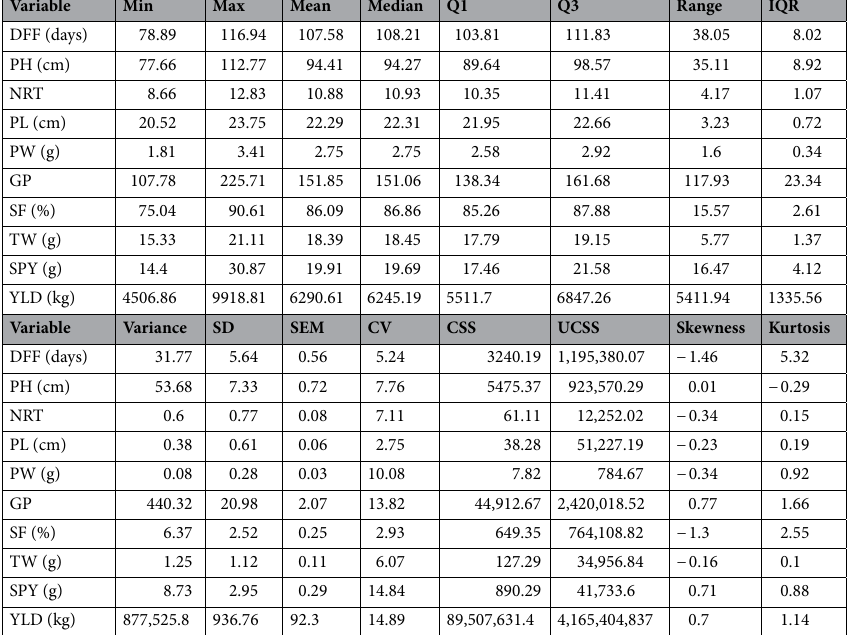
Table 1. Phenotypic variability and Descriptive statistics of traits under study across the environments. Var, Variable; DFF, days to fifty percent flowering; PH, plant height; NRT, number of productive tillers; PL, panicle length; PW, panicle weight; GP, grains per panicle; SF, spikelet fertility; TW, 1000 seed weight; SPY, single plant yield; YLD, plot yield.